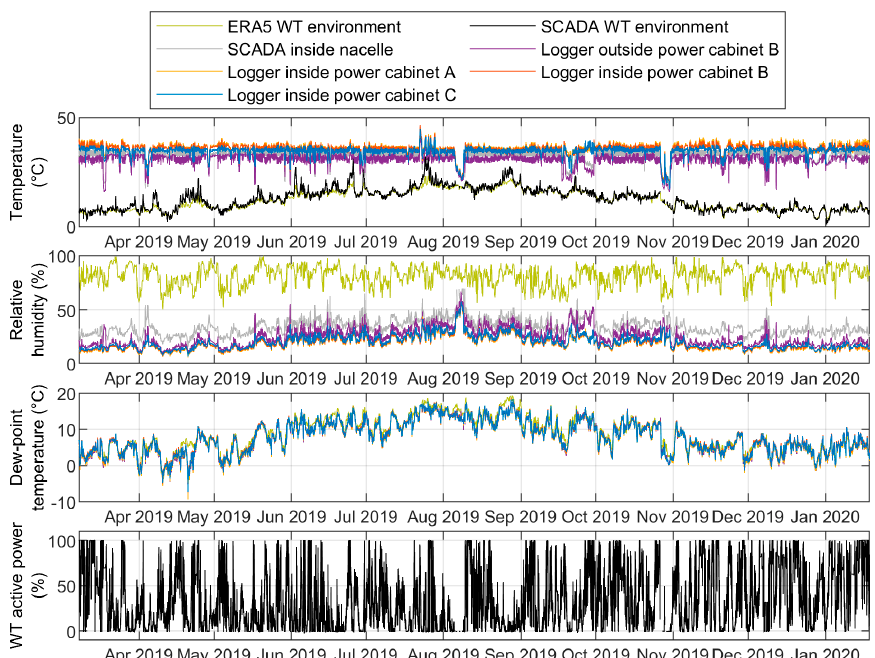
Figure 7. Measured climatic data, SCADA and ERA5 data from an offshore wind turbine in the North Sea with a liquid-cooled converter located in the nacelle.